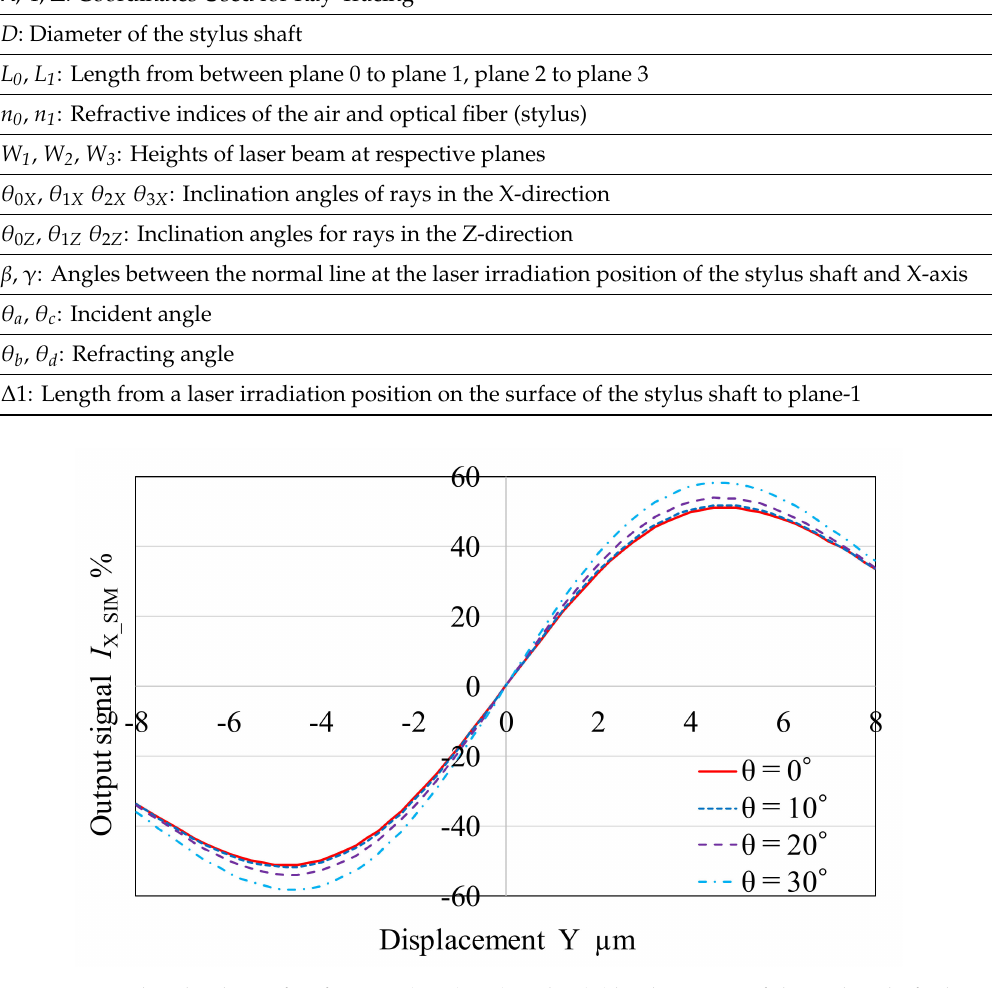
Figure 6. Simulated values of I X for θ = 0 ◦ , 10 ◦ , 20 ◦ and 30 ◦ (displacement of the stylus shaft along Y-axis = ± 2.5 µ